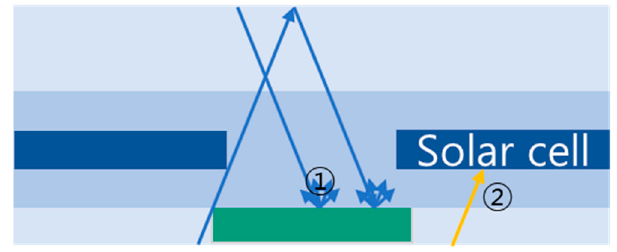
Figure 4. Power gain depending on irradiance.